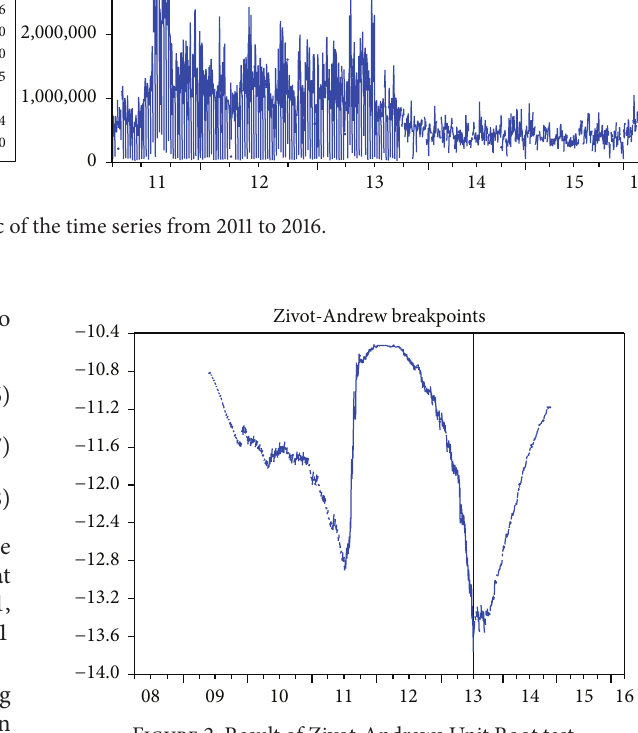
Figure 2: Result of Zivot-Andrews Unit Root